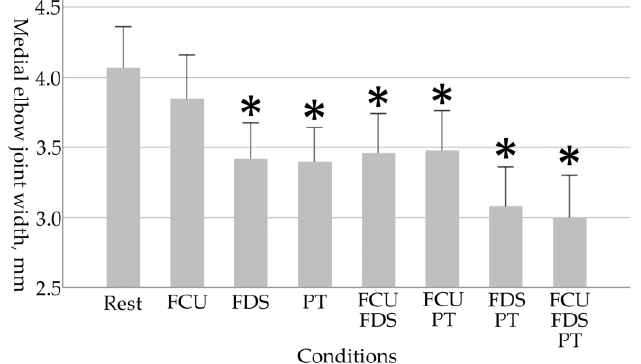
Figure 3. Changes in medial elbow joint width due to selective contraction of the FPMs. A higher value in medial elbow joint width indicates greater elbow valgus laxity. Asterisks indicate significant differences compared to the resting condition ( p < 0.05). Error bars in the graph are standard errors. FPMs, forearm flexor–pronator muscles; FCU, flexor carpi ulnaris; FDS, flexor digitorum superficialis; PT, pronator teres.